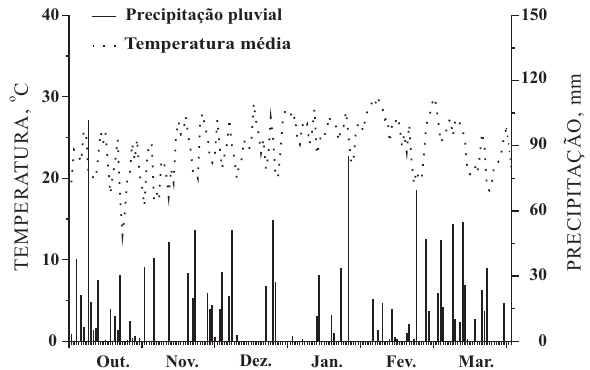
Figura 1. Temperaturas médias diárias e precipitação pluvial diária ocorrida durante a condução do experimento. Os dados de precipitação foram obtidos na Estação Meteorológica do Departamento de Fitotecnia da